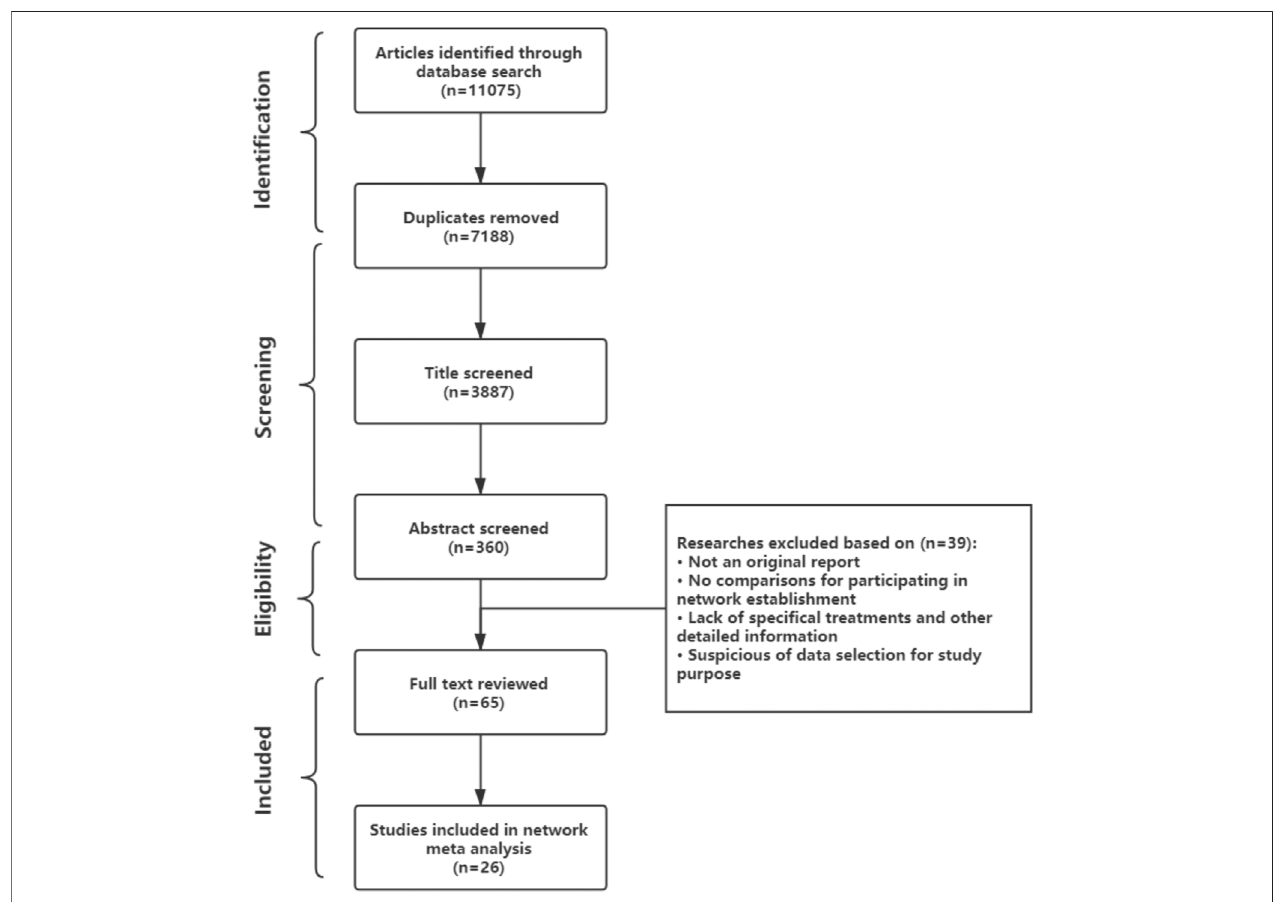
FIGURE 1 | Preferred Reporting Items for Systematic Reviews and Meta-Analyses (PRISMA) fl owchart describing study selection.